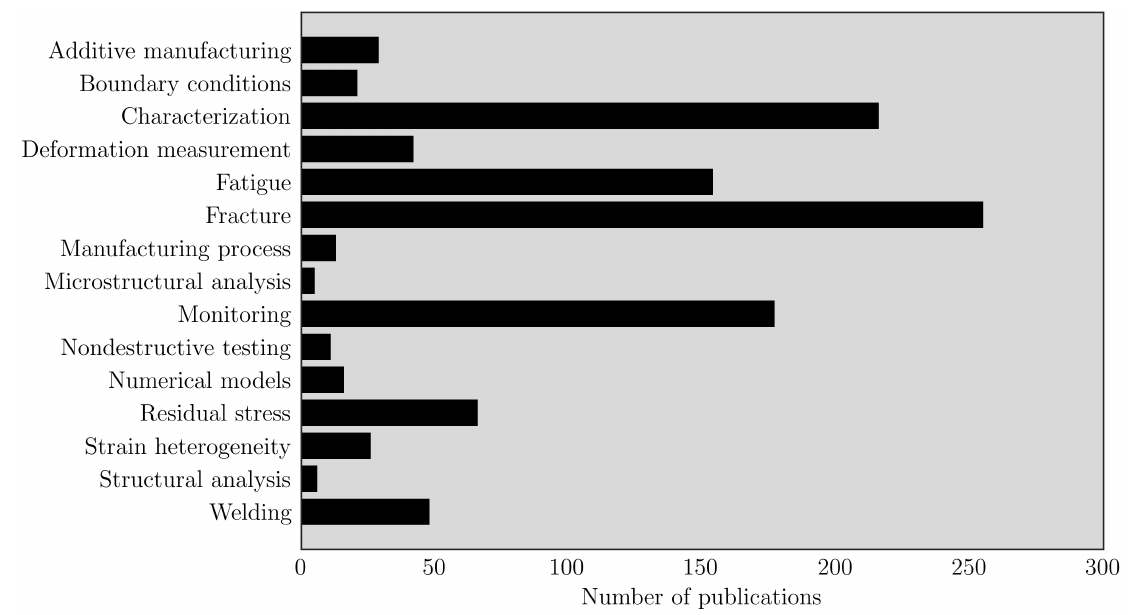
Figure 3. Applications of in situ measurements using